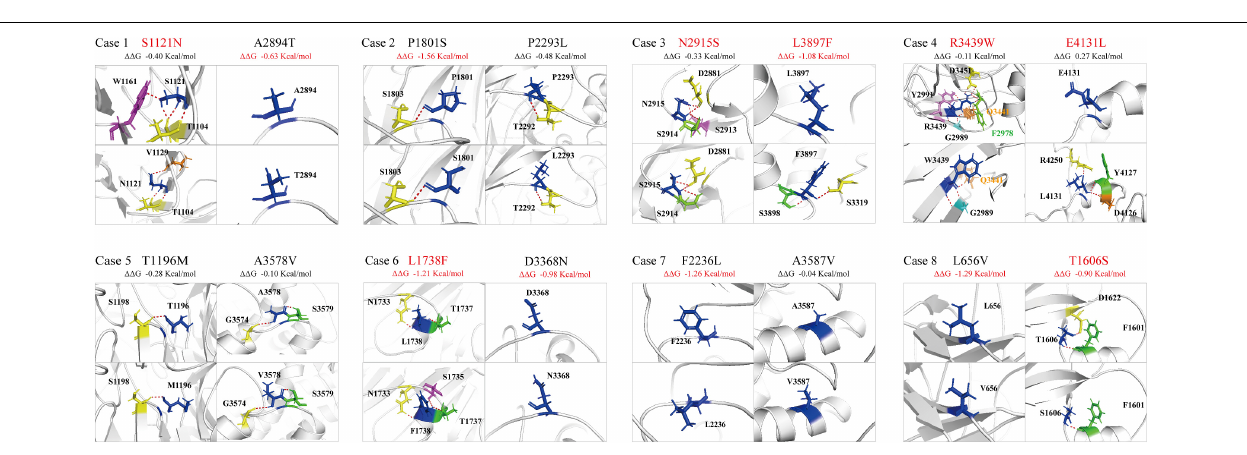
FIGURE 3 | Hydrogen bond changes of the PKD1 mutants. Variants with changes on hydrogen bonding or free energy stability are highlighted in